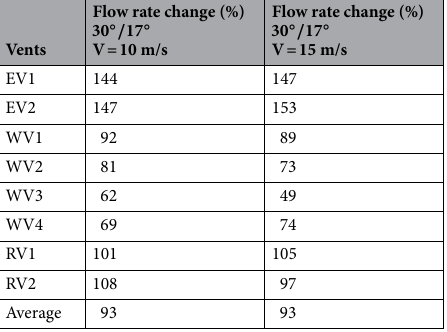
Table 4. Effect of wind direction on natural ventilation of the windmill.